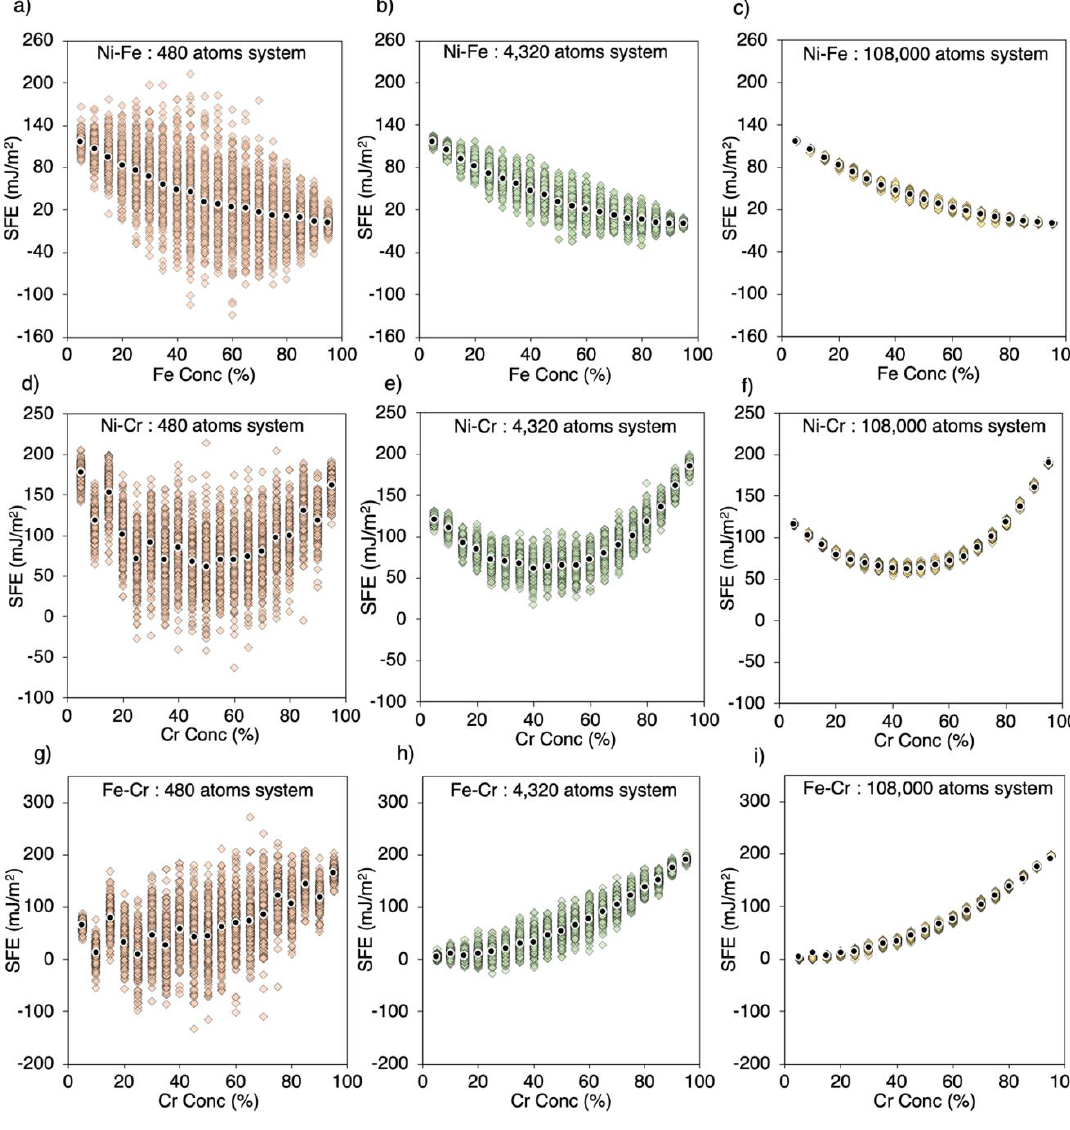
Figure 6. SFE variation across the composition range in ( a – c ) Ni-Fe, ( d – f ) Ni-Cr, and ( g – i ) Fe-Cr at an interval of 5% in 480, 4320, and 108,000-atom systems. SFE variation decreases as the system size increases due to increasing number of nearest neighbor environments that are captured in large system sizes. SFE variation is maximum for the composition near the center of the phase diagram due to larger number of possible nearest neighbor environments compared to the ends of the composition range.